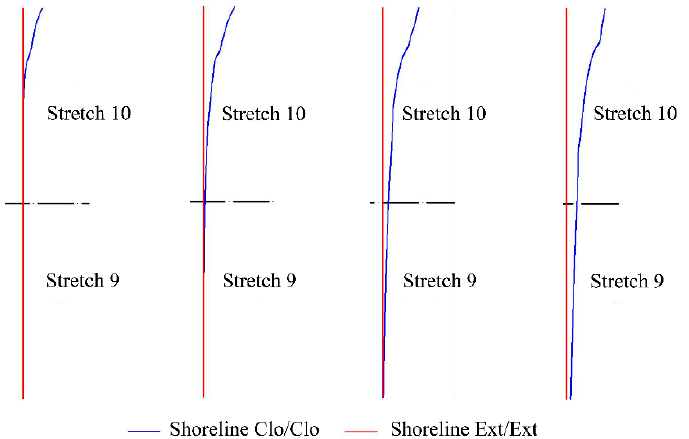
Figure 11. Shoreline position without nourishment after the fifth year of simulation ( θ = 60 ◦ and from left to the right, H = 1 to H = 4 m).